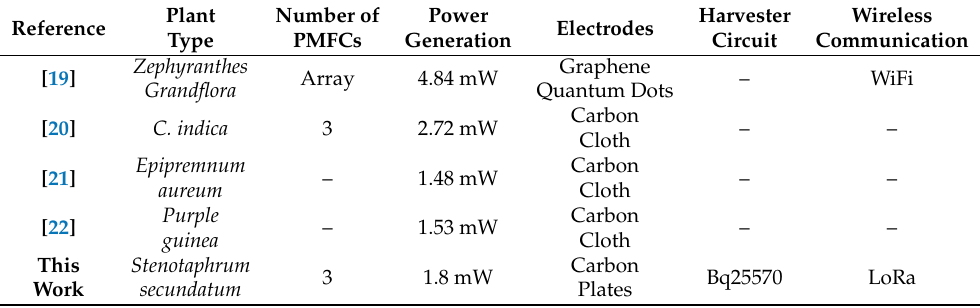
Table 3. PMFC comparative